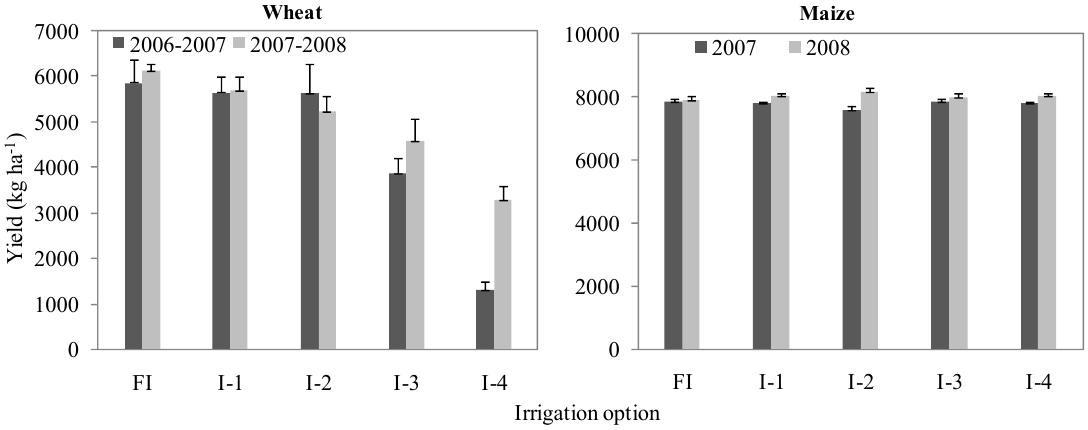
Figure 1. The yield of wheat and maize under different irrigation options.